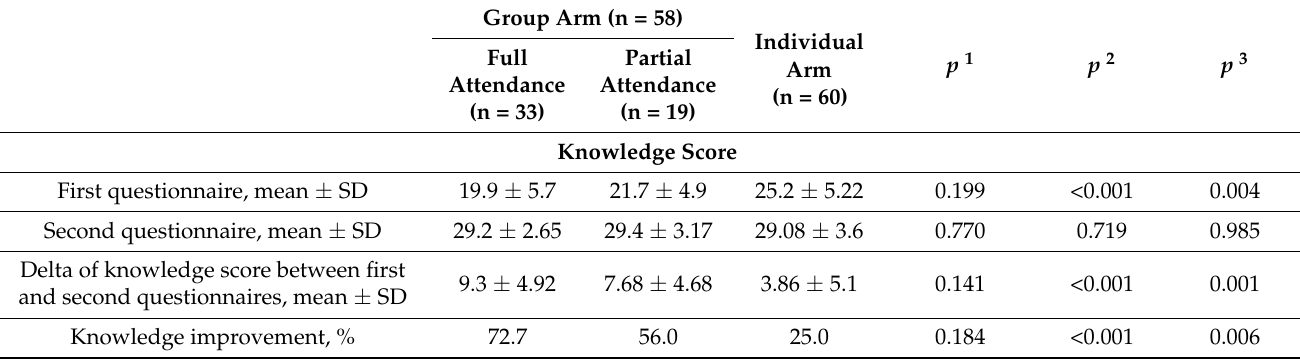
Table 3. Knowledge score and improvement in the two study arms and session